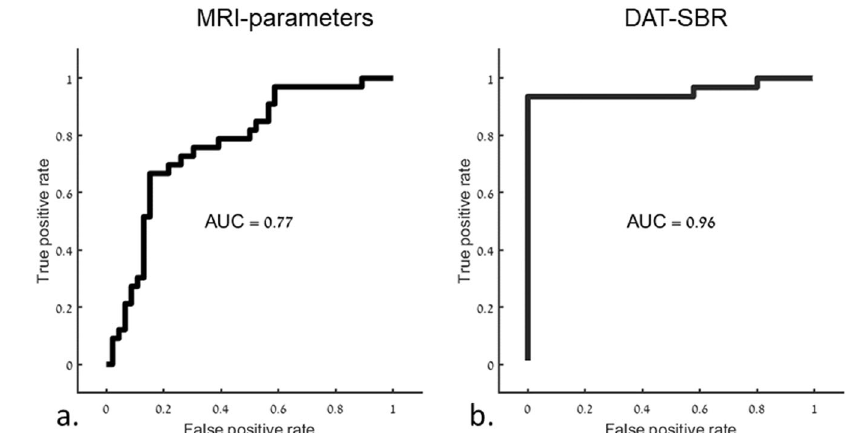
Fig. 1 ROC curves based on MRI-parameters and DAT-SBR. Receiver operating characteristic (ROC) curves for classi fi cation between patients with PD and NMNC. a Based on MRI parameters: b Based on